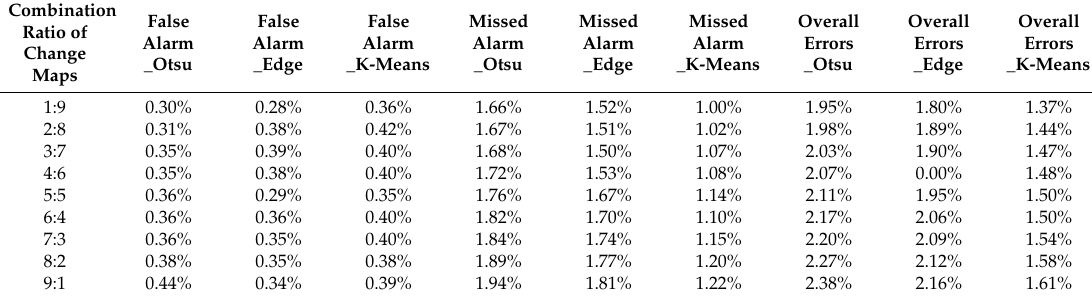
Table 6. Comparison between the change detection results of the three thresholding and clustering methods, with L2 as the basis image in the second study area (scale = 50).